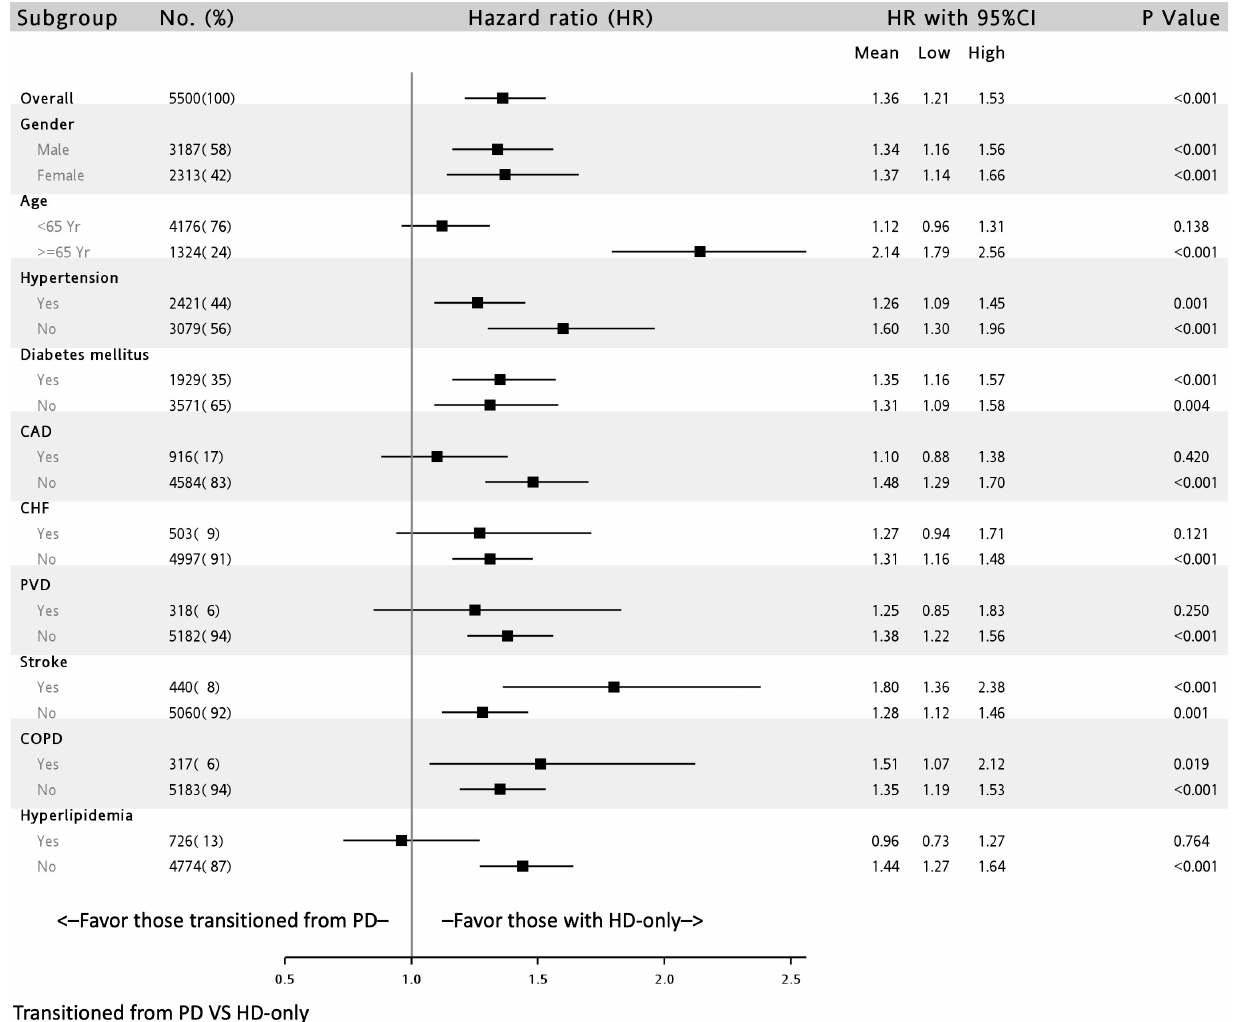
FIGURE 3 | Subgroup analysis of all-cause mortality of patients undergoing dialysis with and without previous peritoneal dialysis in a multivariable adjusting model ∗ . ∗ Full adjusted model is the same as that in Table 2 . CAD, coronary artery disease; CHF, congestive heart failure; PVD, peripheral vascular disease; COPD, chronic obstructive pulmonary